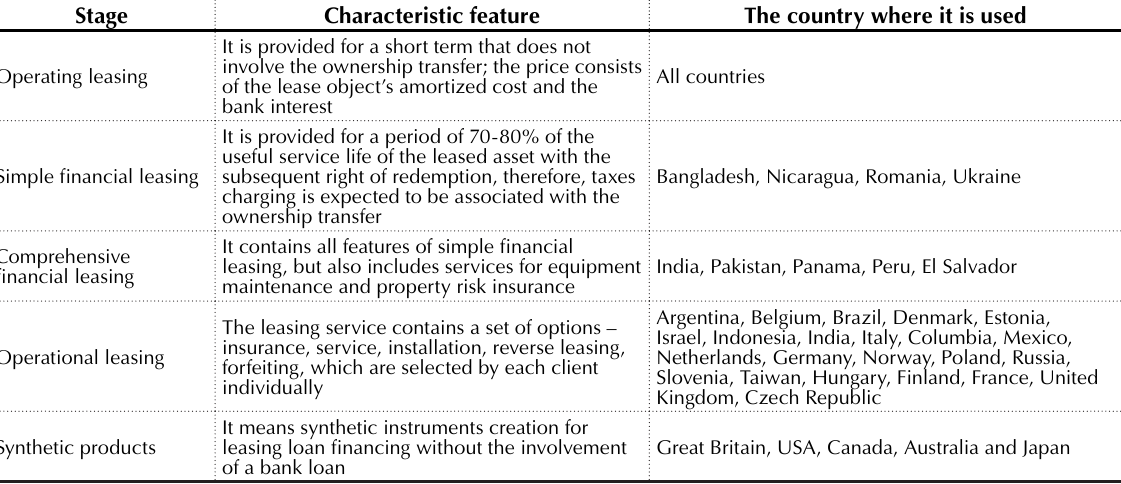
Table 1. Characteristics of the leasing evolution stages in the world Source: proposed by authors on the basis of Nair et al. (2004), Canada Market Review, Japan Market